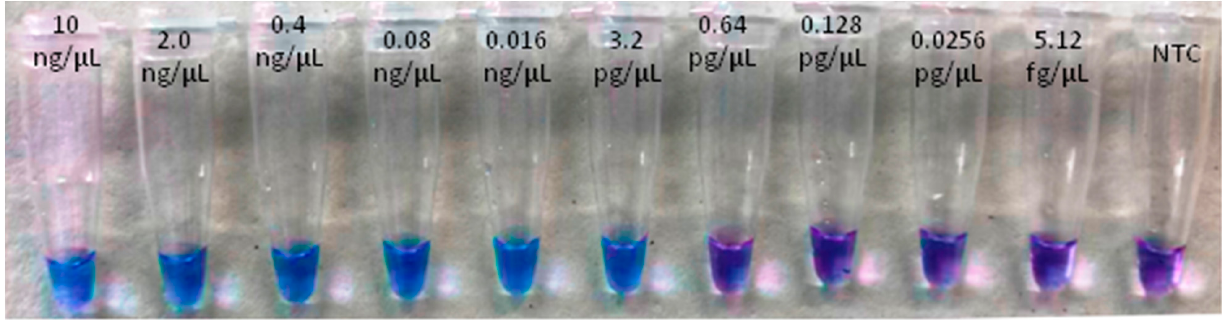
Figure 5. LoD assay of Visual LAMP based on artificial DNA from WTB frass using serial 1:5 dilutions (from 10 ng/µL to